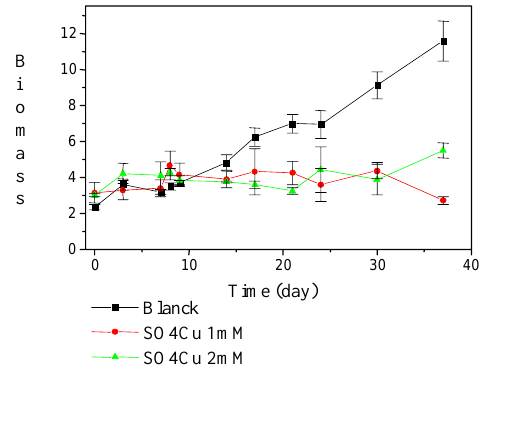
effect on grindelic acid 4